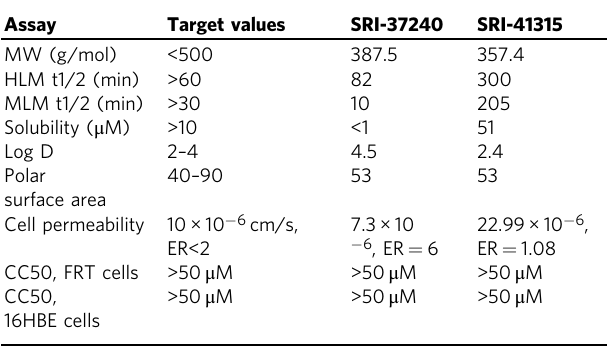
Table 1 Physiochemical properties of SRI-37240 and